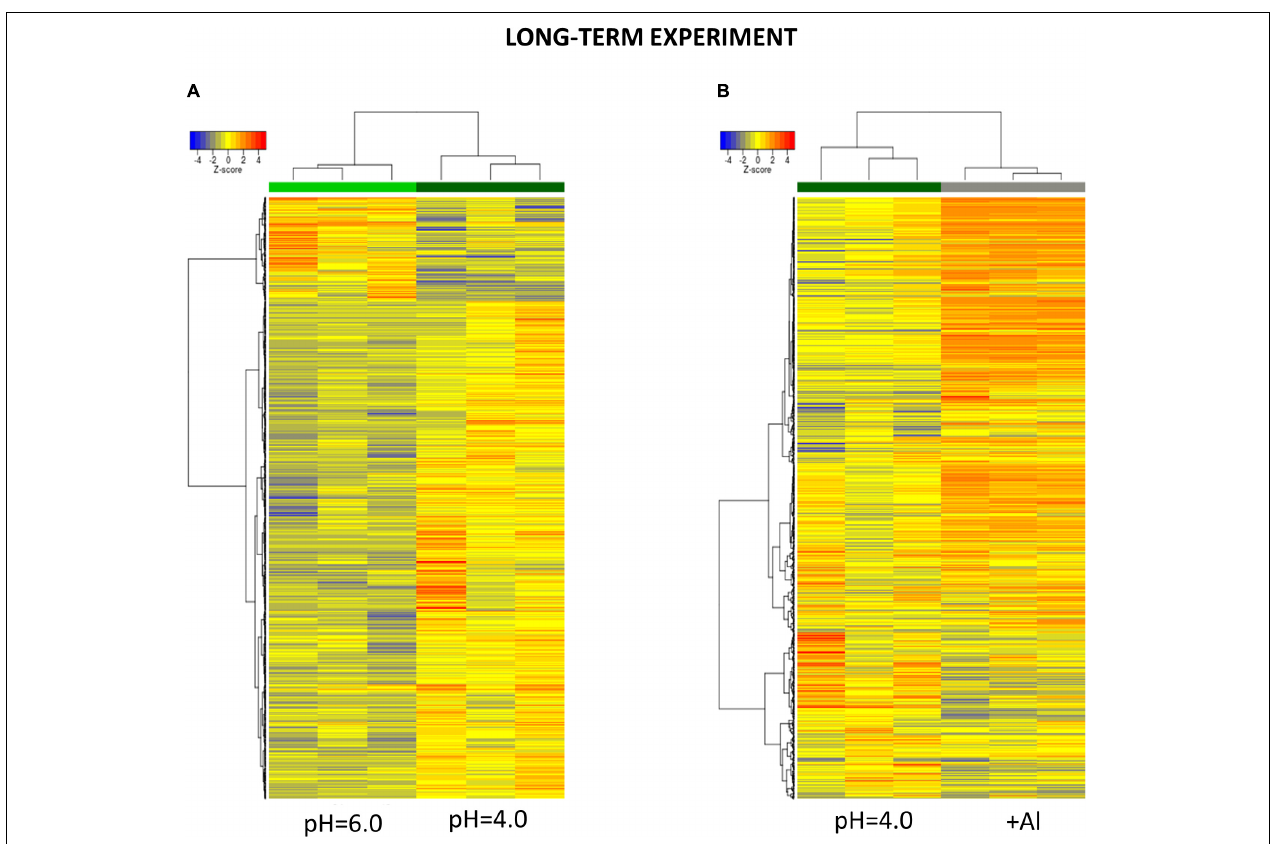
FIGURE 9 | Hierarchical clustering of samples using distance based on Pearson’s correlation coefficient with Ward D2 linkage algorithm for a set of genes differentially expressed in barley root meristems in the long-term experiment. Gene counts were regularized log (rlog) transformed with library size-wise normalization, scaled and centered to be represented as z -scores in the log2 scale. The heat map represents the relative expression levels of DEGs. (A) The comparison between pH = 4.0 and pH = 6.0. (B) The comparison between Al-treatment at pH = 4.0 and pH = 4.0 without